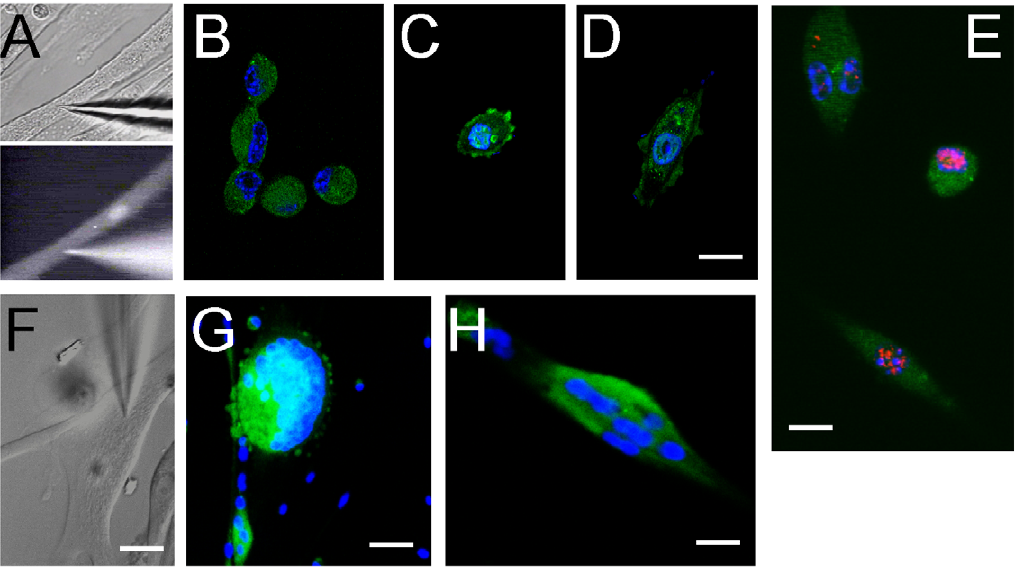
Figure 3. Barx2 induces cleavage of mouse myotubes. A–D. Barx2/pcDNA3 or empty pcDNA3 plasmids were mixed with Alexa Fluor H 488- conjugated dextran and then injected into immature (stage 1) myotubes. Cultures were stimulated with growth medium and fluorescently labeled myotubes were monitored for signs of cleavage and appearance of labeled mononucleated cells. Scale bar represent 10 m m. E. BrdU labeling after microinjection of myotubes. Single Alexa Fluor H 488-conjugated dextran-labeled cells occasionally incorporated BrdU suggesting they has re-entered the cell cycle. Scale bar represent 10 m m. F–H . Mature (stage 2) myotubes were microinjected and examined as in A-D. No myotube cleavage was observed. Scale bars represent F–10 m m, G - 50 m m, H–20 m